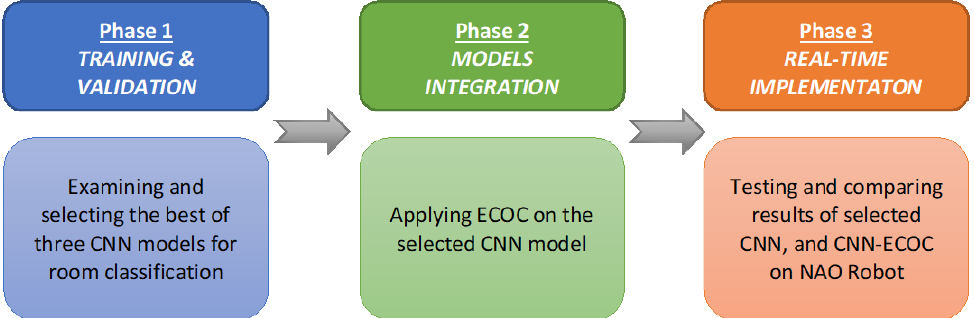
Figure 3. Process of simulation and real-time implementation.